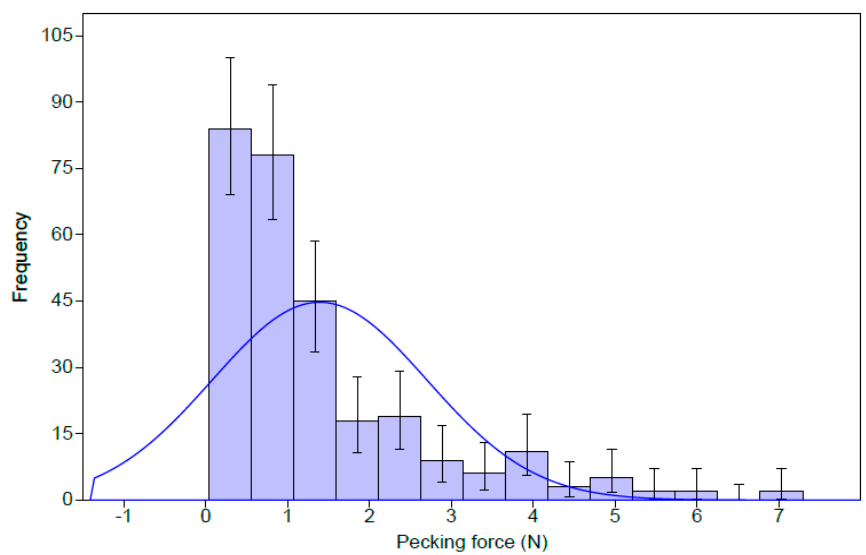
Figure 6. Frequency histogram of pecking force values.